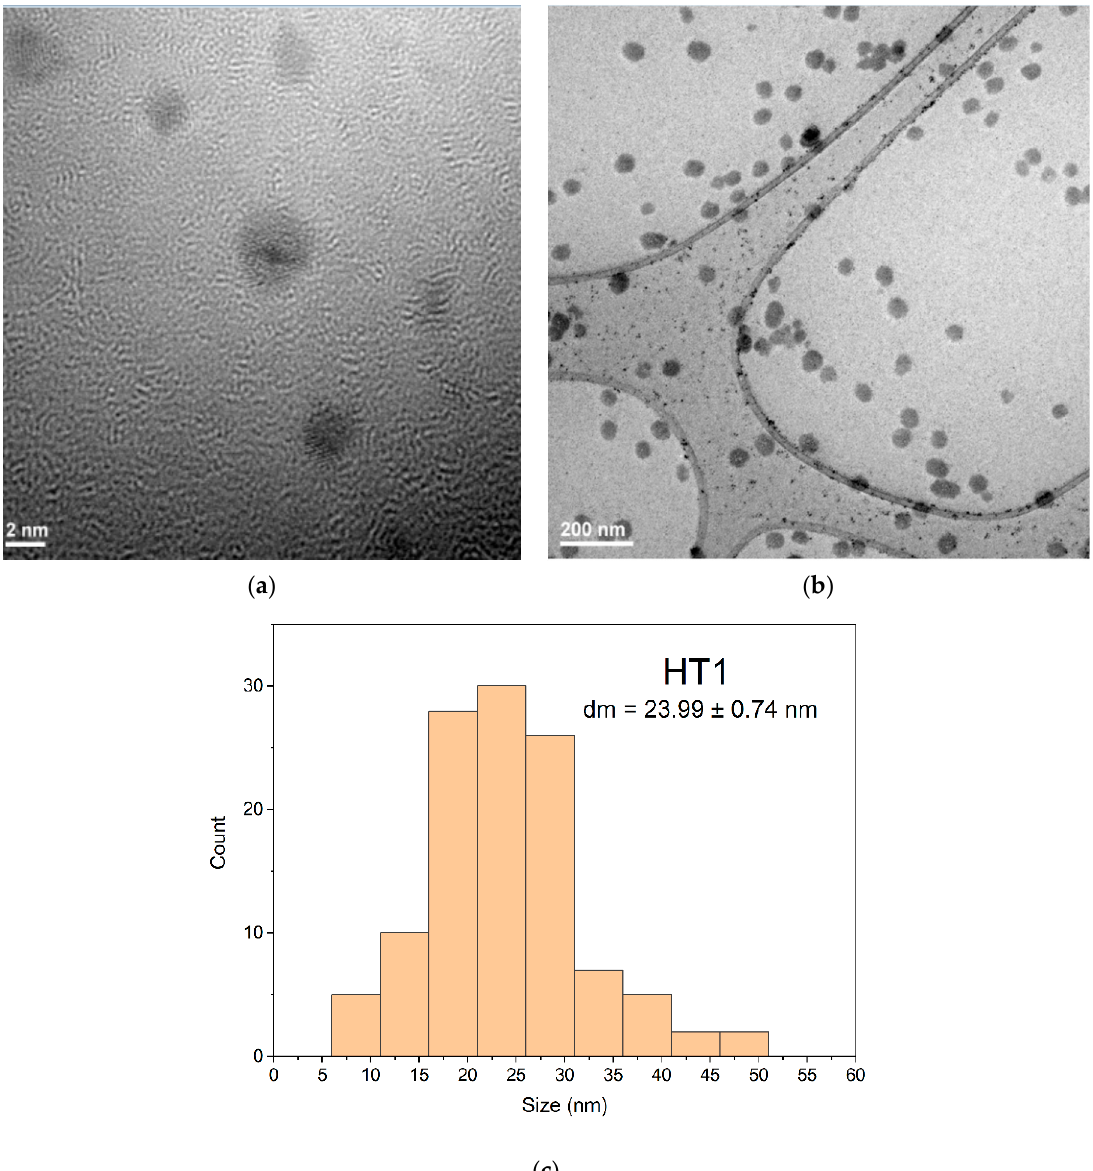
Figure 12. TEM images for the AgNPs sample HT1 at two different magnifications ( a )—high magnification and ( b )—low magnification) and the appropriate histogram ( c ).